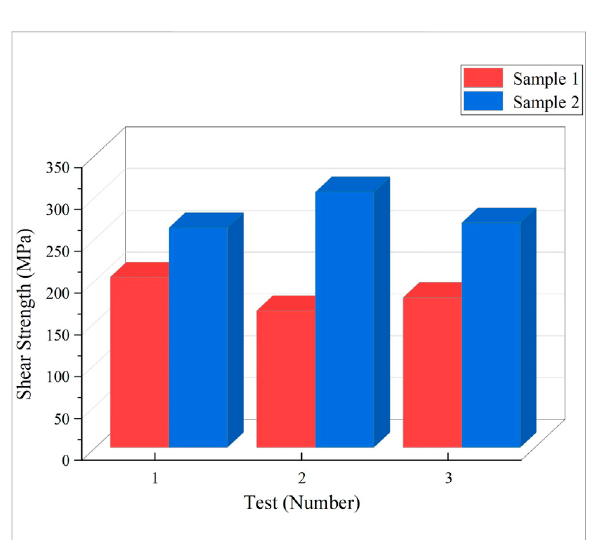
FIGURE 7 Shear strength of brazed joints with different brazing